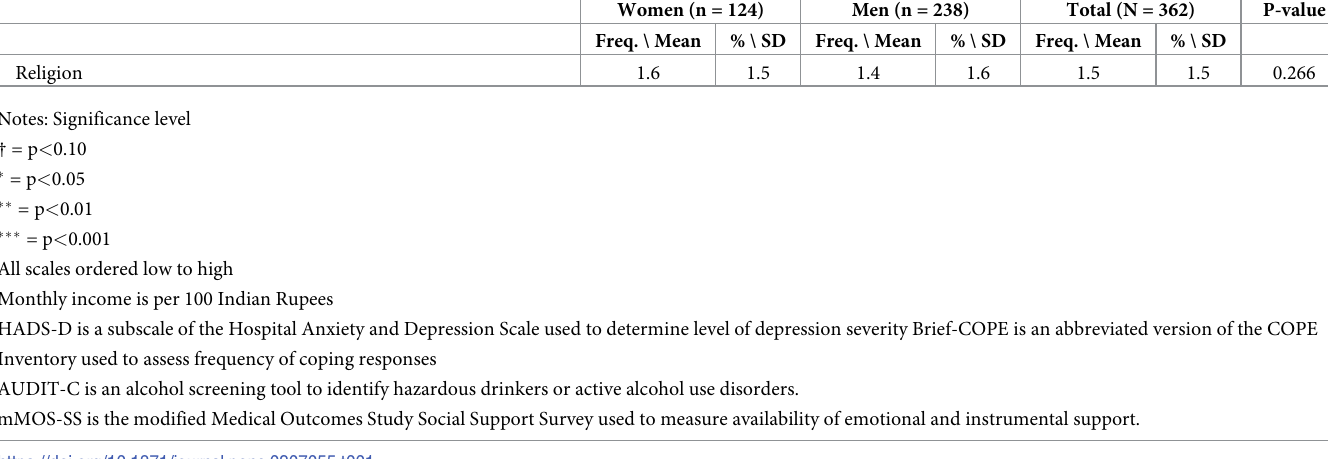
Table 3 presents the multiple linear regression coefficients and 95% confidence intervals for covariates of depression severity, stratified by gender. The model for women explained 43% of the variance in depression severity among women. The model for men explained 53% of the variance in depression severity among men. Among women, depression severity